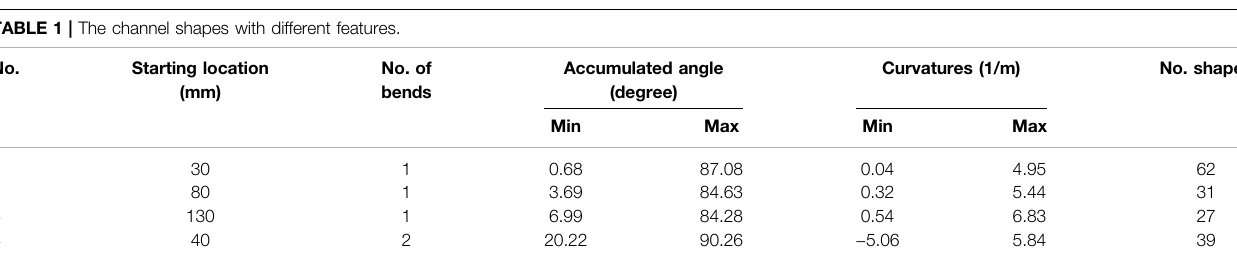
Curvatures (1/m) No.